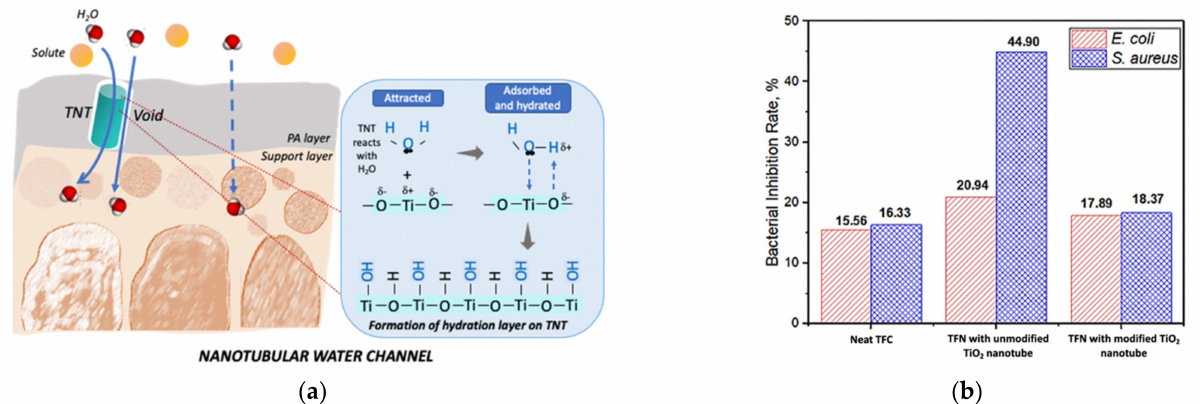
Figure 4. ( a ) Schematic illustration of surface hydroxyl groups and nanochannels created by TiO 2 nanotubes in a polyamide layer of an RO TFC membrane [127], ( b ) bacterial inhibition efficiency of neat and nanocomposite TFC membrane against E. coli and S. aureus [128]. Reprinted with